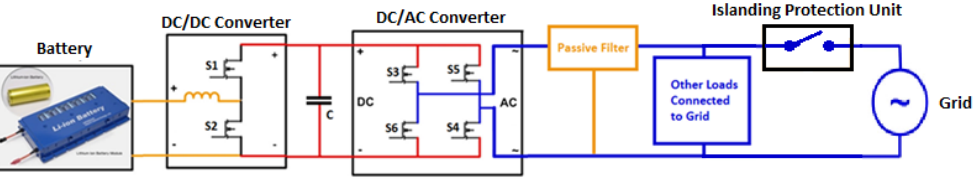
Figure 3. Simulation model. Table 1. Parameters of the simulation system.